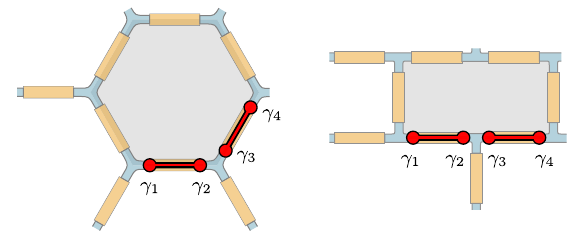
FIG. 3. Left diagram: Hexagonal cell hosting four Majoranas encoding one qubit. The single-qubit Clifford gates can be performed by braiding in the double T junction in the lower part of the cell. In a network of such cells, each cell has up to six neighbors. Right diagram: Such a hexagonal lattice can also be realized with only two different wire orientations using a brick- wall geometry of superconducting